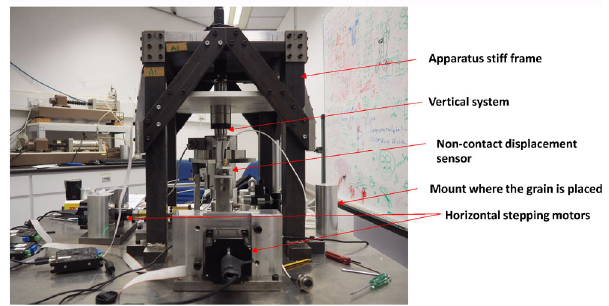
Fig. 1 The new large-size micromechanical inter-granule loading apparatus at City University of Hong Kong (frame width equal to 40 cm).